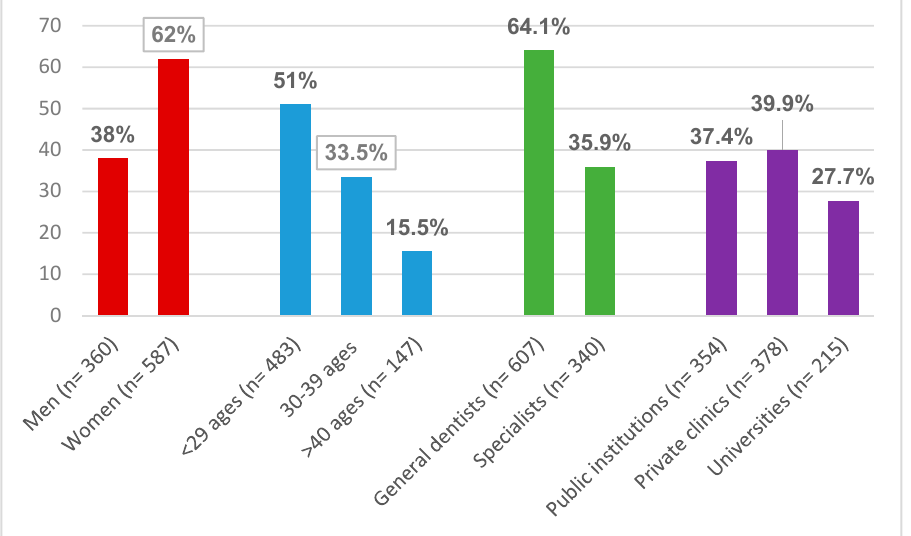
Figure 1. The demographic data of the participants.